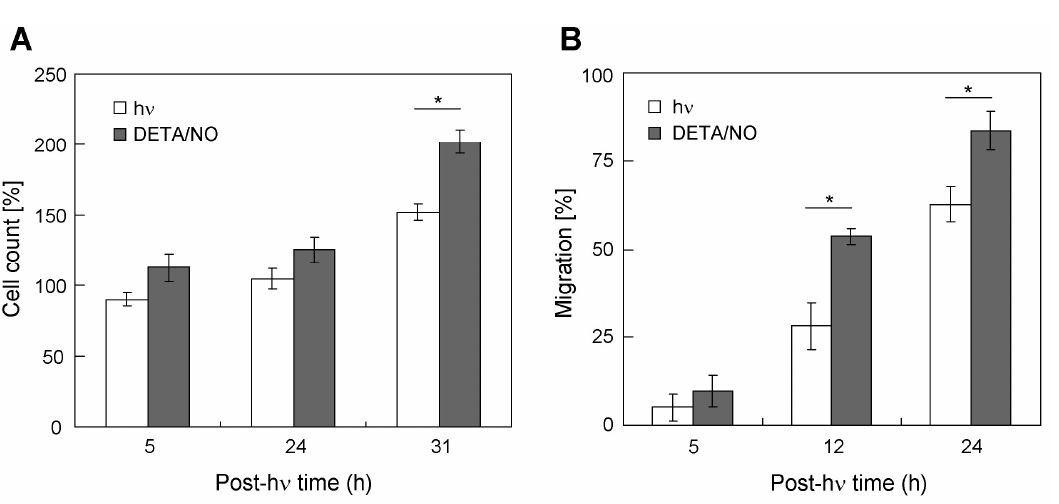
Figure 5. E ff ects of a chemical NO donor on proliferation and migration of MDA-MB-231 cells. ( A ) Proliferation. Cells at ~40% confluency in 10% serum-containing RPMI medium were incubated in the absence (open bars) or presence (filled bars) of DETA / NO at a starting concentration of 50 µ M. Cell counts were determined by Image-J analysis of photomicrographs acquired after the indicated incubation times. Plotted data are means ± SEM ( n = 3); * p < 0.05 vs. control. ( B ) Migration. Cells in 10% serum-RPMI were incubated in the absence (open bars) or presence (filled bars) of 10 µ M DETA / NO, and at the indicated times evaluated for migration by gap-closure assay. Data are means ± SEM ( n = 3); * p < 0.01 vs. control.